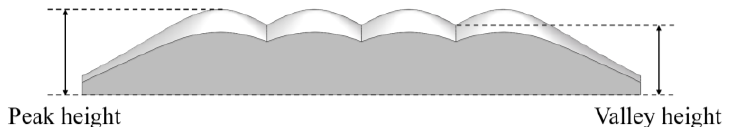
Figure 10. Schematic diagram of peak height and valley height. Table 1. Record of experimental parameters.